Question: Express in one sentence what the figure is showing.
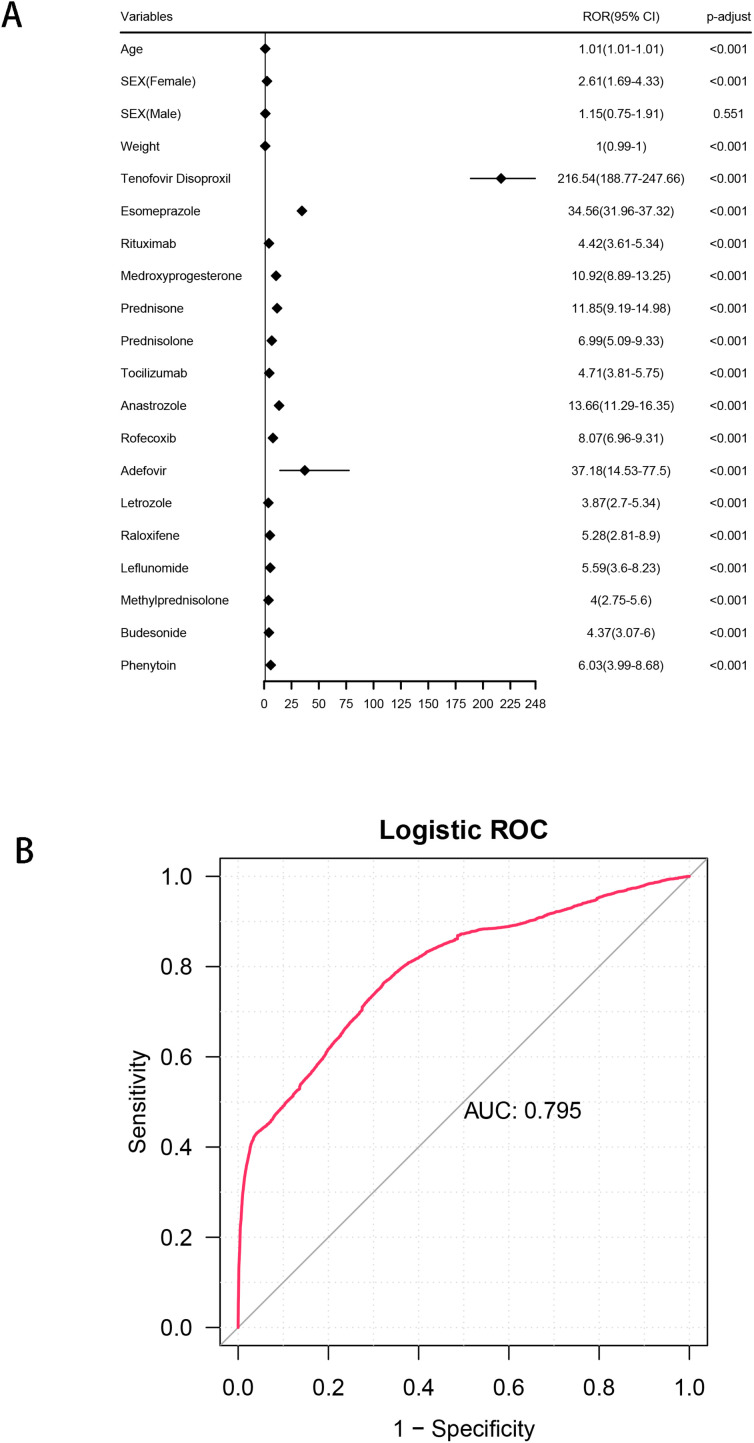
Answer: Identification and performance evaluation of independent risk factors for drug-induced OP. (A) Multivariable logistic regression analysis showing the adjusted ORs and 95% CIs for each risk factor. Bonferroni-corrected p-values (P-adjust) were used to determine statistical significance, with P-adjust < 0.01 considered significant. (B) ROC curve of the logistic regression model. An AUC greater than 0.7 indicates good model performance.